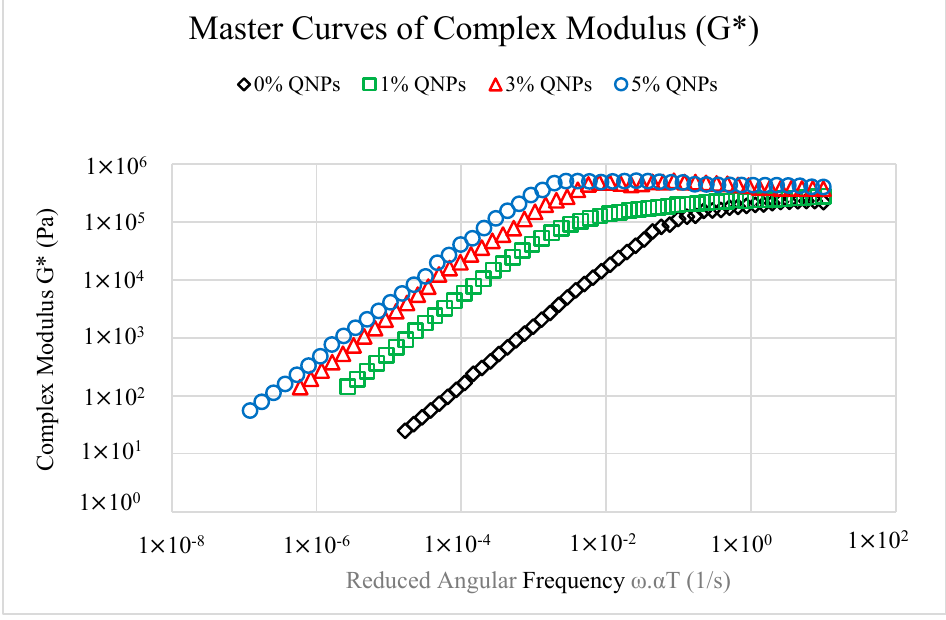
Figure 10. Master curves G* of all samples.